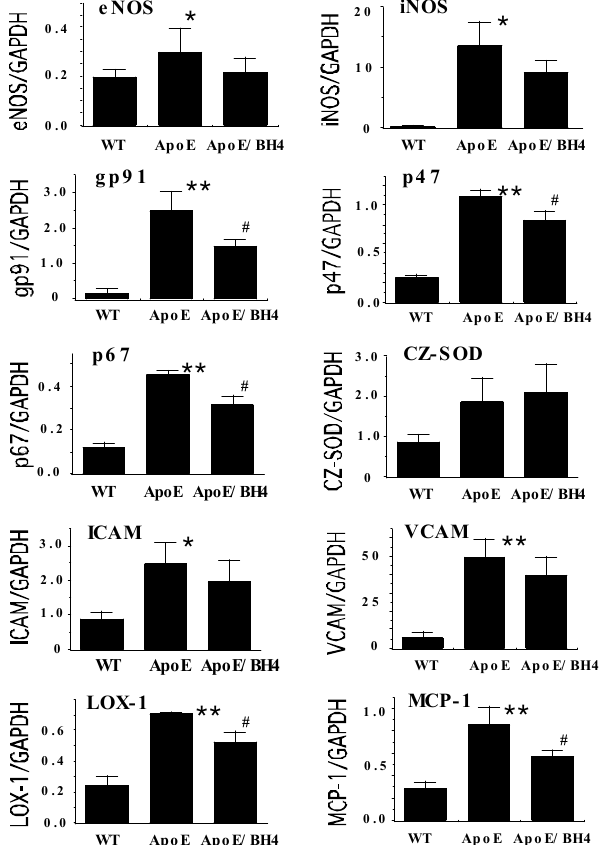
Figure 5. Aortic mRNA expression levels for eNOS, iNOS, gp91, p47, p67, CZ-SOD, ICAM, VCAM, LOX-1, and MCP-1 in WT, ApoE-KO, and ApoE-KO/BH4 mice by RealTime PCR. Data represent the means ± SD of at least three independent experiments, and are expressed as a ratio of GAPDH. *P < 0.05, **P < 0.01 compared with WT mice, and #P<0.05 compared with ApoE-KO